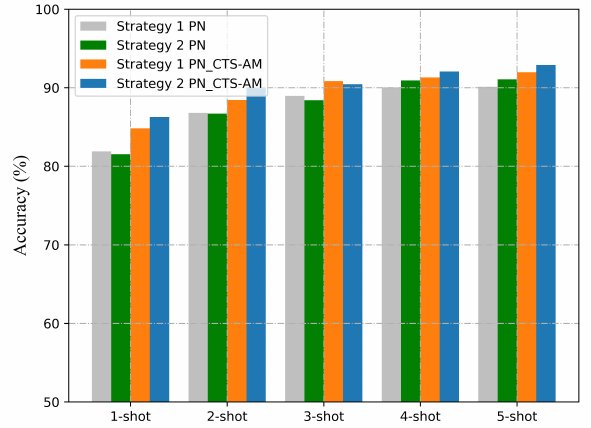
Figure 10. The average recognition accuracy for distinct